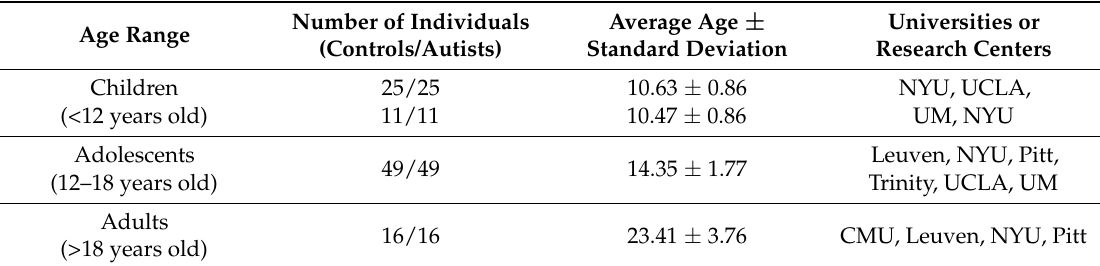
Table 1. Individuals from the public database ABIDE (Autism Brain Image Data Exchange) used in